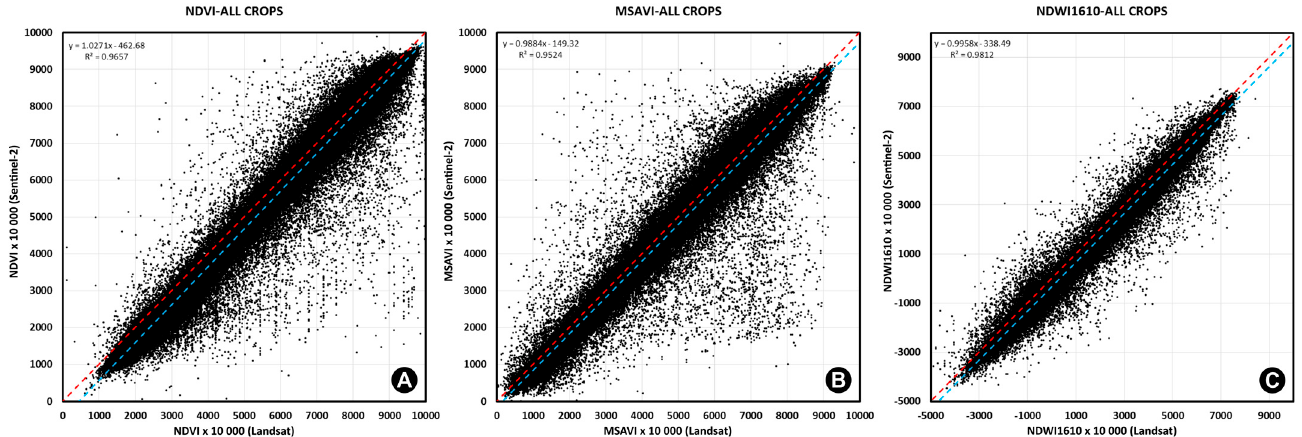
Figure 3. Scatter plots of spectral vegetation indices derived from Sentinel-2 MSI and Landsat OLI and calculated for agricultural crops of interest during the period 2017–2020 across the entire Czech Republic: NDVI ( A ); MSAVI ( B ); and NDWI_1610 ( C